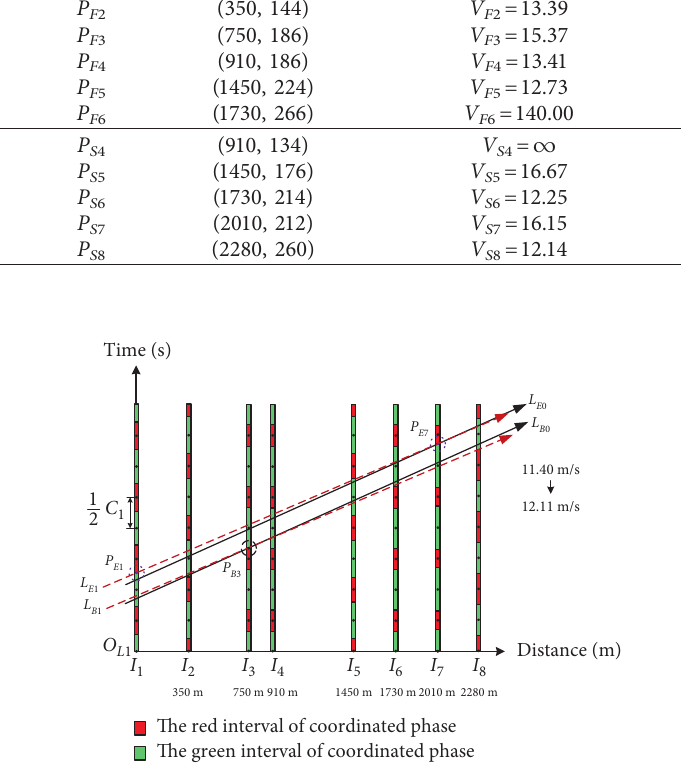
Figure 13: Updating the sets of bottleneck intersections.